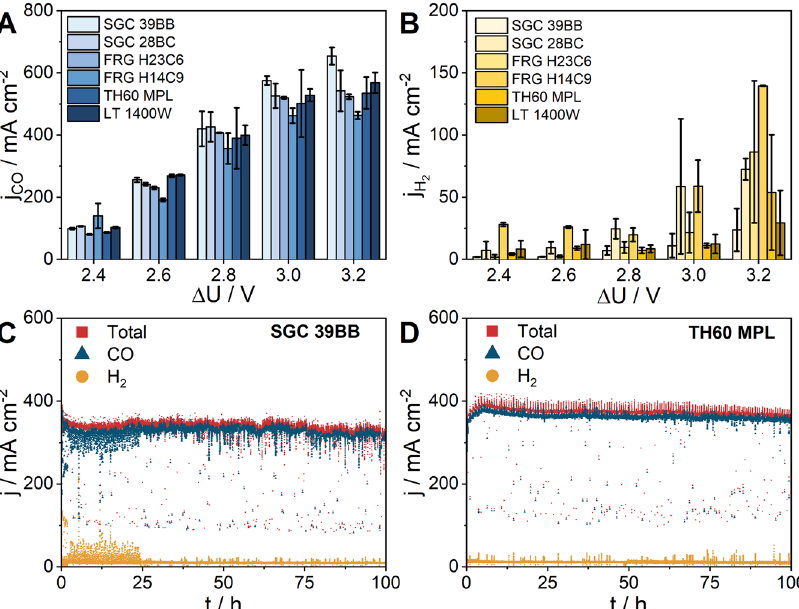
Fig. 6 The performance of a CO 2 electrolyzer cells with different gas diffusion layers. A , B Partial current densities for CO (shades of blue) and H 2 (shades of yellow) formation during CO 2 reduction reaction at different cell voltages using a 0.1 M CsOH anolyte and C , D 100-hours long electrolysis at Δ U = 2.8 V in 0.05 M CsOH anolyte. Total current densities are shown with red squares, while the partial CO and H 2 current densities are represented with blue triangles and yellow circles, respectively. The CO 2 feed rate was 12.5 cm 3 cm − 2 min − 1 , and the electrolyzer cell temperature was 60 °C for all measurements. The error bars in A and B represent the deviations from two consecutive analyses during two separate measurements.